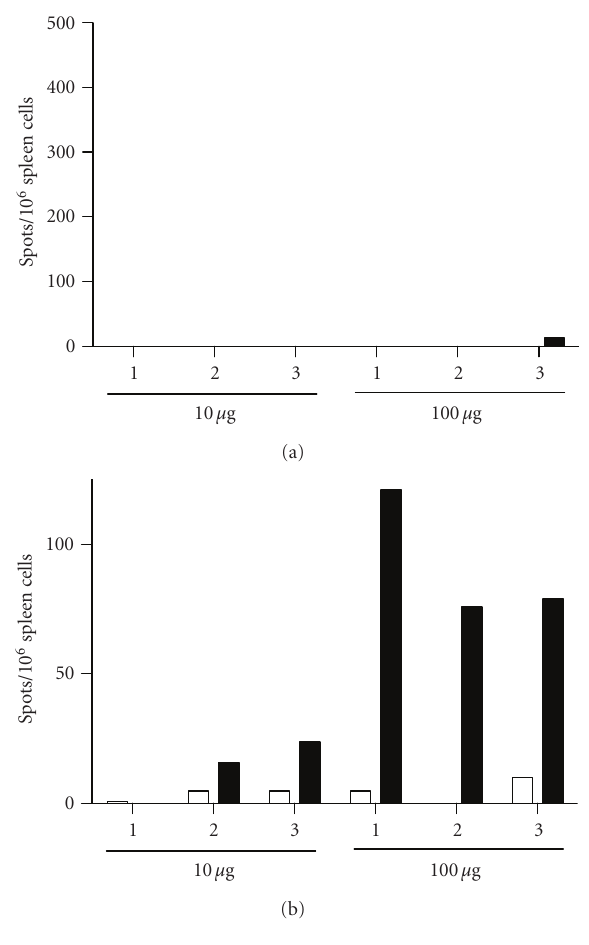
Figure 6: Number of IFN γ - and IL-4-producing cells in mice immunized i.p. with soluble β -gal (A) and β -gal adsorbed to alum as an adjuvant (B). Soluble β -gal was administered twice five days apart, while β -gal/alum was administered only once. Dose of β -gal administered in each experiment is indicated (10 μ g or 100 μ g). Mice were killed 11 days after the initial injection, and antigen-specific cytokine-producing spleen cells were enumerated by ELISPOT assay. Open bars represent IFN γ spots and black bars represent IL-4 spots. Results are representative of three separate